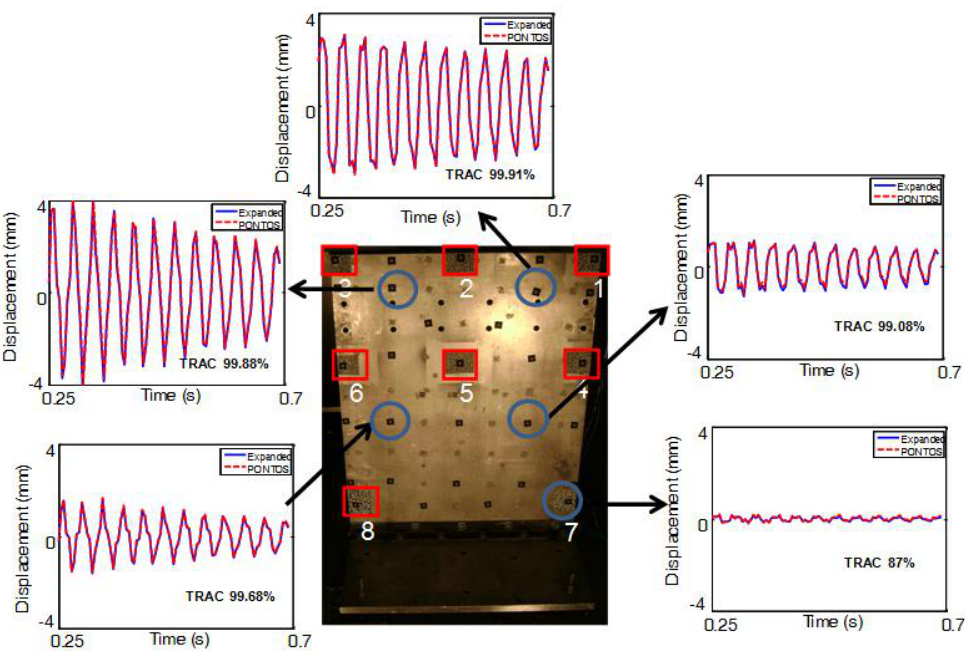
Fig. 14. Overlay of the displacement responses from predicted solution using first five modes for expansion and PONTOS at five different locations; expansion performed using sensor configuration